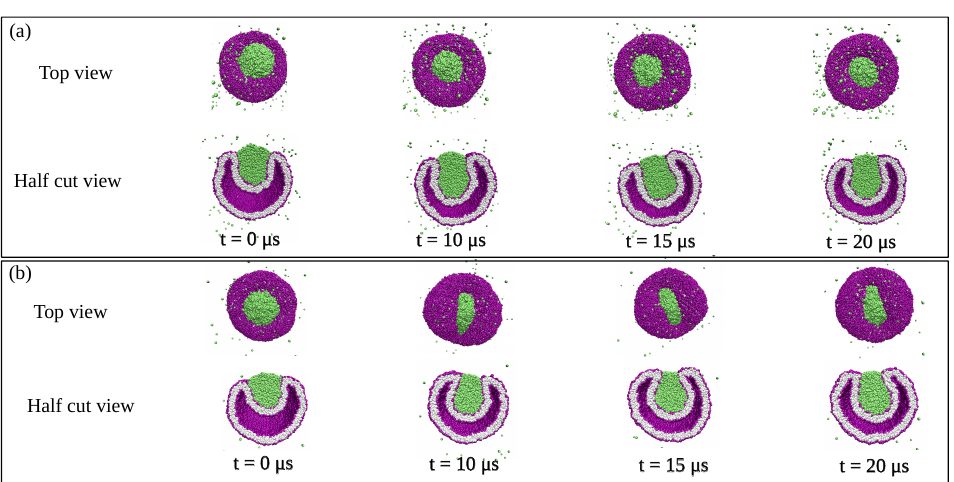
Figure 24. Stalled engulfment of large nanodroplets (green) by the vesicle membranes (purple- grey) as observed in molecular dynamics simulations [30]. Droplet engulfment can proceed in an axisymmetric or non-axisymmetric manner, depending on the lipid numbers, N ol and N il , which are assembled in the outer and inner leaflets of the bilayer membranes: ( a ) For N ol = 5400 and N il = 4700, the engulfment process proceeds in an axisymmetric manner as can be seen from the circular shape of contact line and αβ interface (green); and ( b ) For N ol = 5700 and N il = 4400, both the contact line and the αβ interface attain a non-circular shape which implies a non-axisymmetric morphology of vesicle and droplet. The lipid numbers in ( b ) are obtained from those in ( a ) by reshuffling 300 lipids from the inner to the outer leaflet. Vesicle and droplet have a diameter of 37nm and 19.6nm,